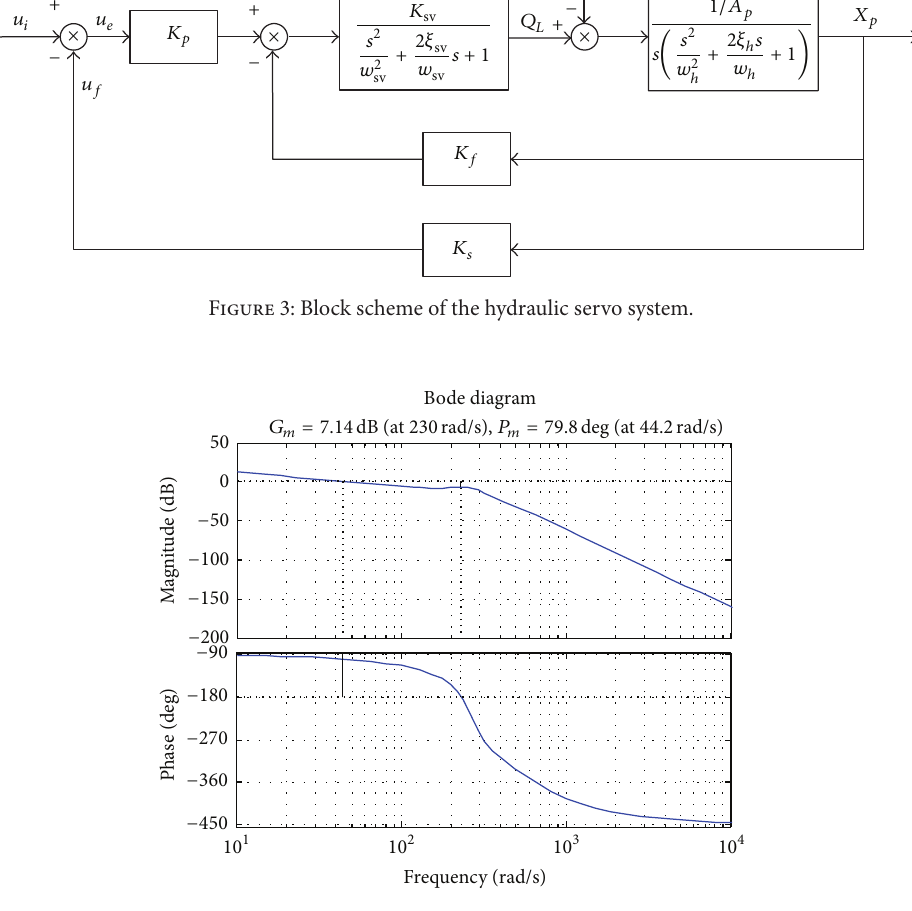
Figure 4: The amplitude and phase frequency characteristics of the servo